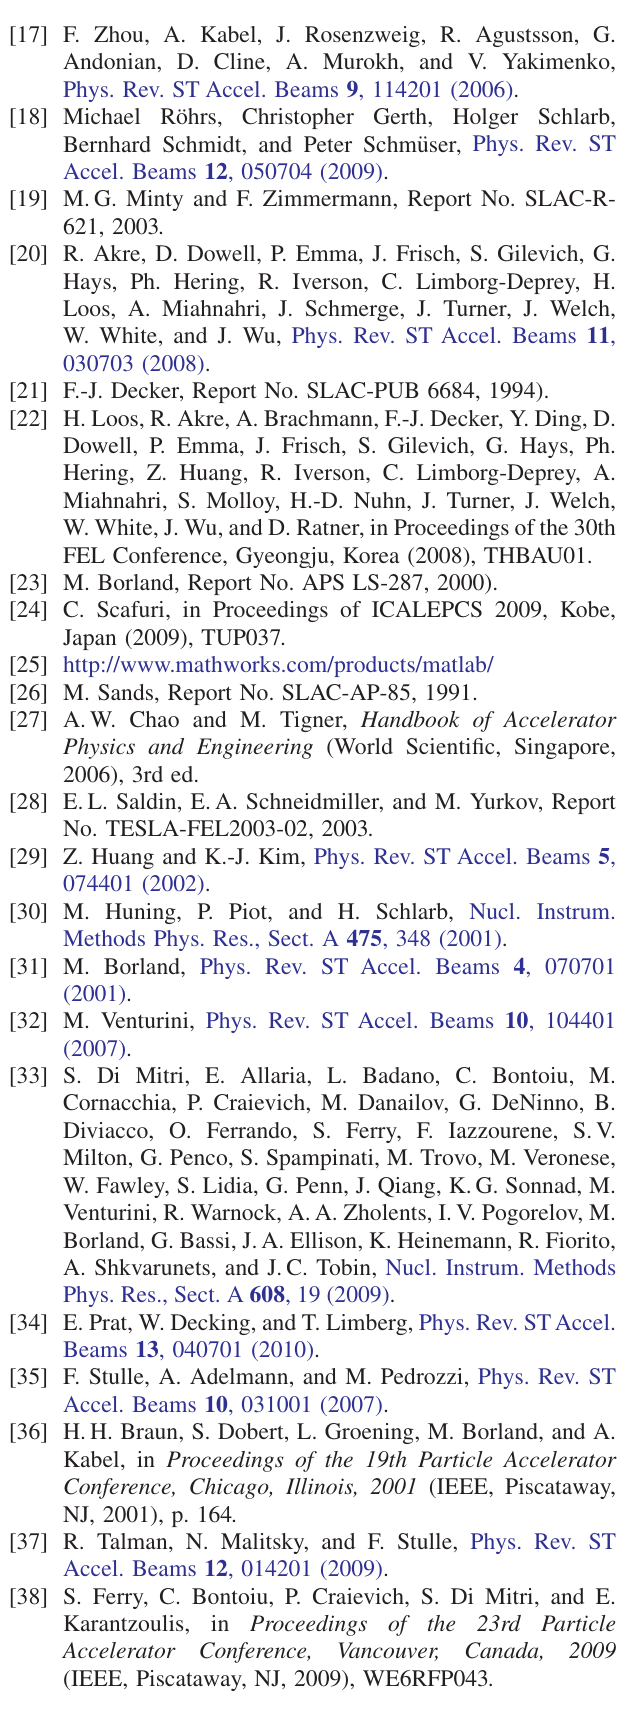
C ¼ 6 : 5 . The horizontal dispersion in the middle of BC1 is 255 mm. First, the particle energy distribution in the middle of BC1 is mapped by selecting 1 mm open window between the left and the right blade, where the beam horizontal extension is approximately 12 mm. The total charge transmitted after beam scraping is detected at a charge monitor downstream of